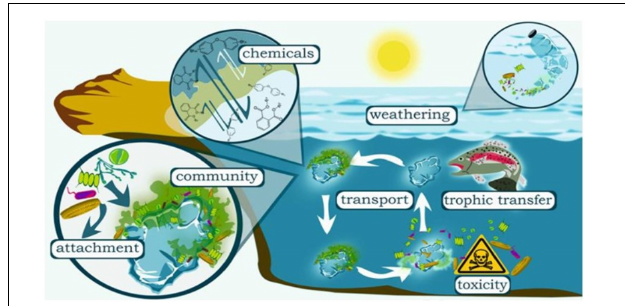
FIGURE 5 | Abiotic and biotic plastic transformation into microplastics and leaching (Rummel et al., 2017). Reproduced with permission from Environmental Science and Technology Letters 2017, 4, 7, 258–267, available at https://pubs.acs.org/doi/10.1021/acs.estlett.7b00164. Copyright 2017, ACS Chemistry for